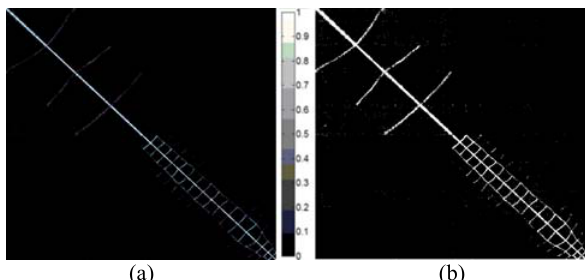
Figure 2. The result for the first image group: (a) similarity graph, (b) overlap graph (see text for details)